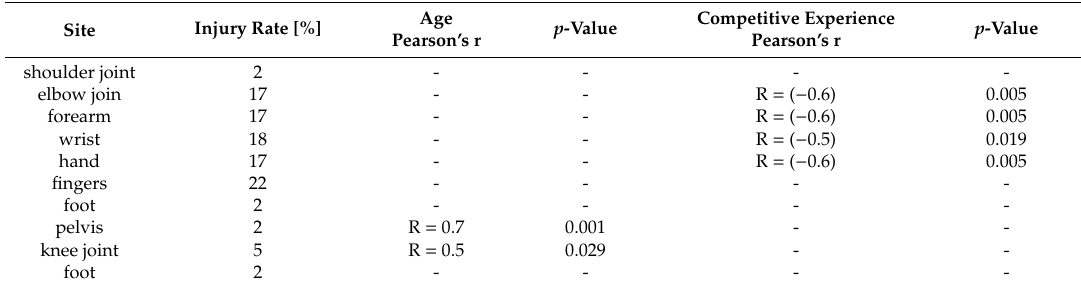
Table 2. Site of injuries vs. age and competitive